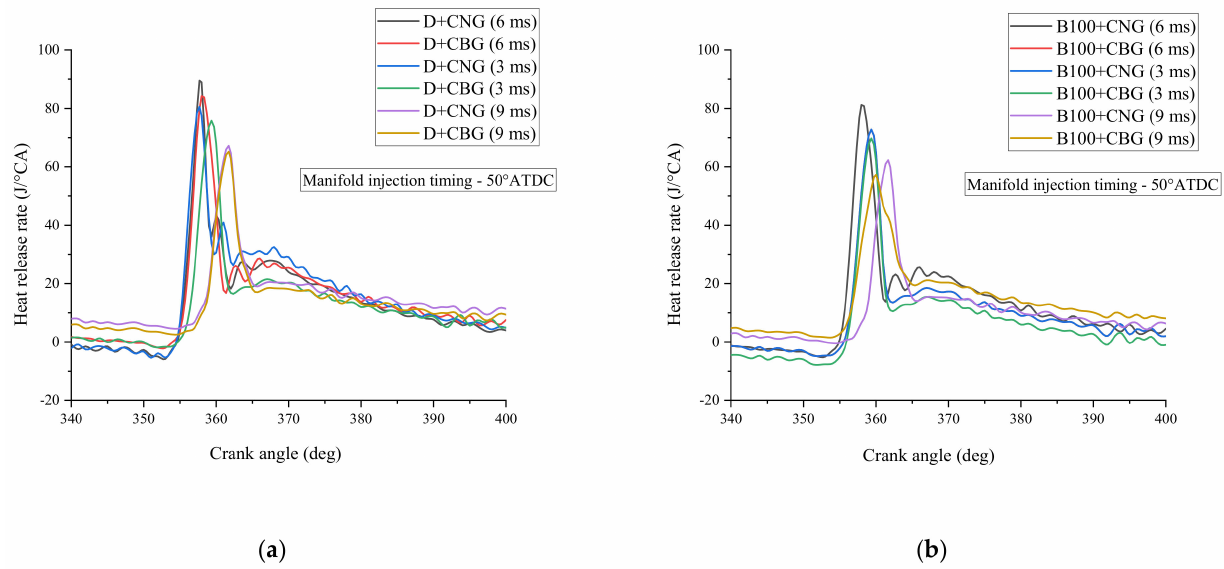
Figure 15. Variation of HRR with CA at different IDs. ( a ) Variation of HRR with CA for diesel as DIF. ( b ) Variation of HRR with CA for B100 as